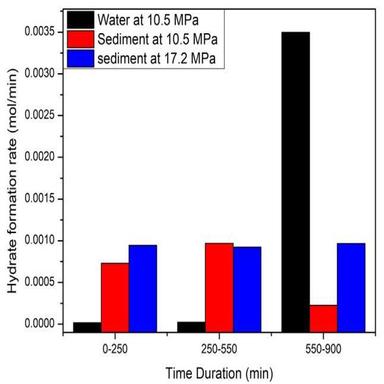
Variation in gas moles during formation of hydrates in sediments at 17.2 MPa.